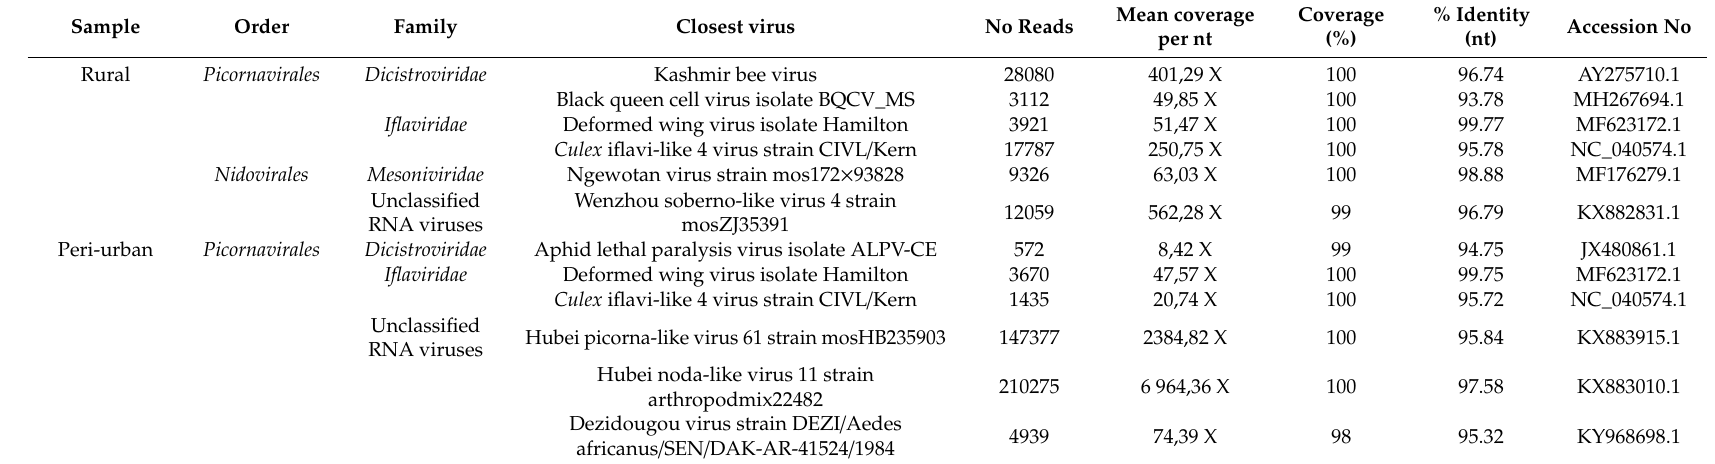
Table 3. Near-complete viral genomes obtained by NGS on honey-baited FTA cards. Viral assignations with a genome coverage higher than 98% and identities higher than 95% are